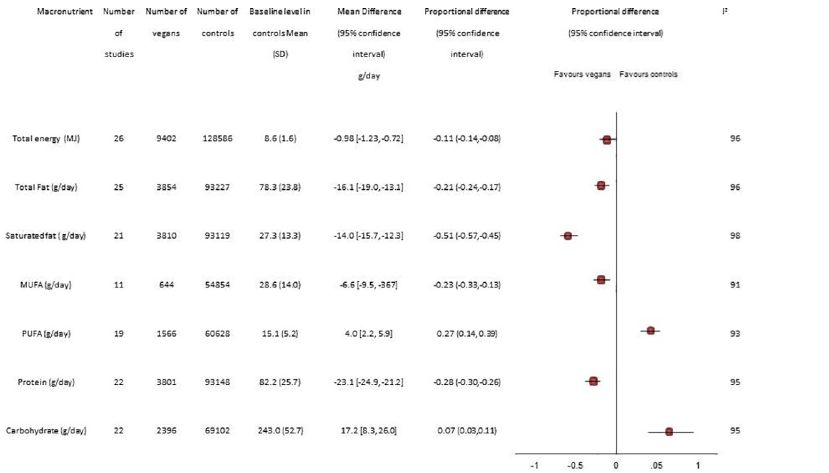
Fig 3. Macronutrient intake in vegans compared to omnivores.